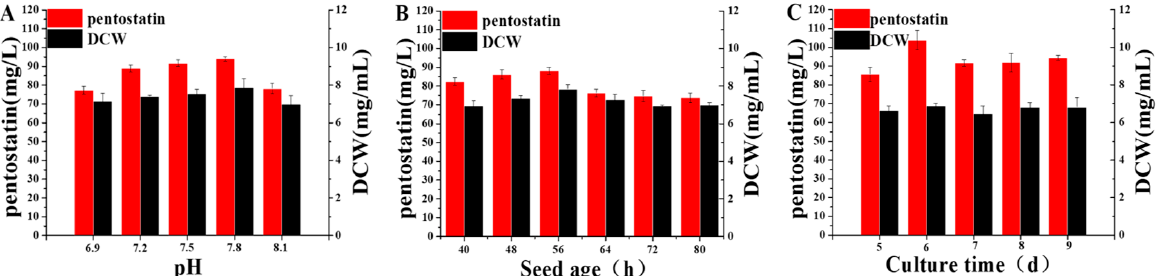
Figure 7. Effect of the initial pH of the fermentation medium ( A ), seed age ( B ) and culture time ( C ) on pentostatin production and biomass of Actinomadura sp. S-15.